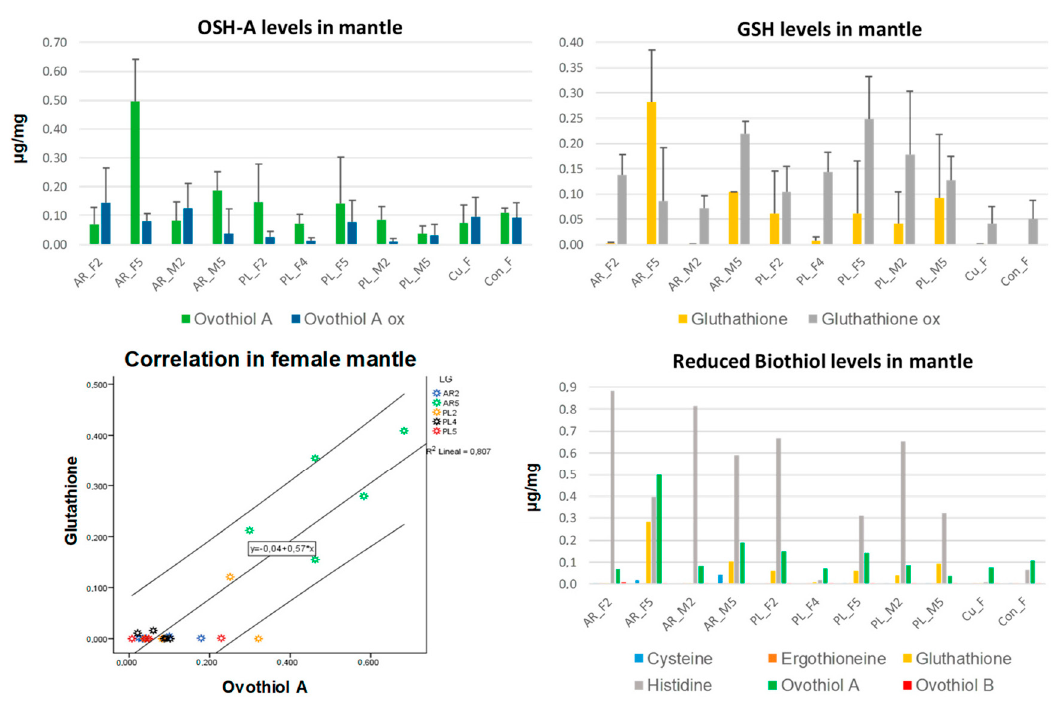
Figure 6. Ovothiol A and glutathion concentrations in mantle of male and female mussels from Arrilizue and Plentzia. Graphs show the concentration of reduced and oxidized biothiols in the mantles (F = female; M = male) of mussels from Arriluze (AR) or Plentzia (Pl) at di ff erent stages of gametogenesis (2, 4 or 5). Concentrations in female mantle of mussels exposed to copper (Cu) for 7 days is also shown together with that of their respective controls. Correlation analysis between mantle concentration in reduced OSH-A and GSH is also